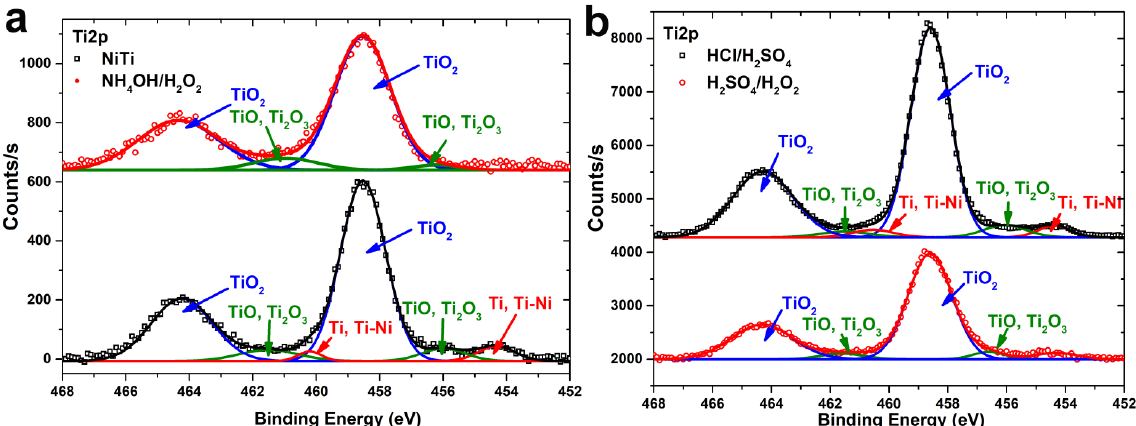
Figure 8. High-resolution Ti2p XPS spectra of polished NiTi and etched in NH 4 OH/H 2 O 2 -120 min samples ( a ) and etched in HCl/H 2 SO 4 -120 min and H 2 SO 4 /H 2 O 2 -120 min ( b ).